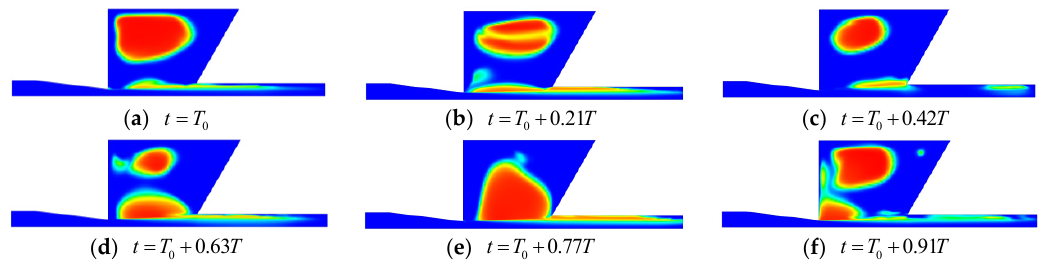
Figure 14. Time evolution of cavity volume during one typical cycle.